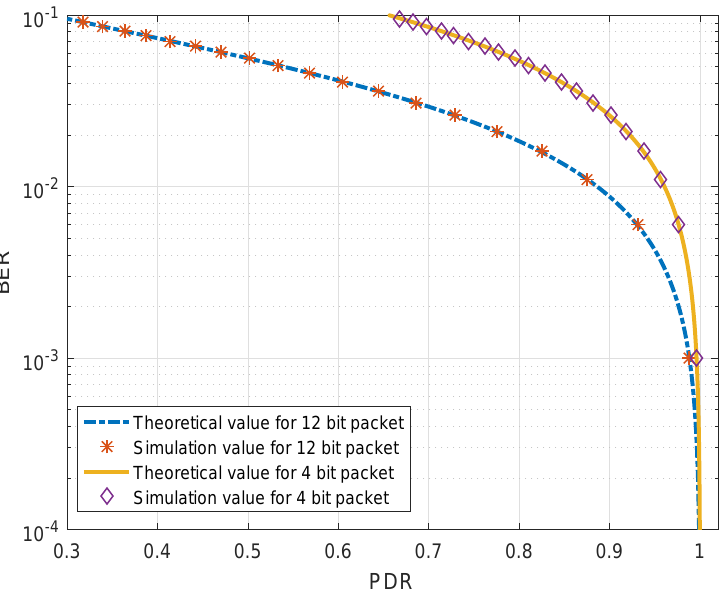
Figure 9. Validation of the packet delivery ratio (PDR) and bit error rate (BER) relationship in (11) using 4 bit and 12 bit